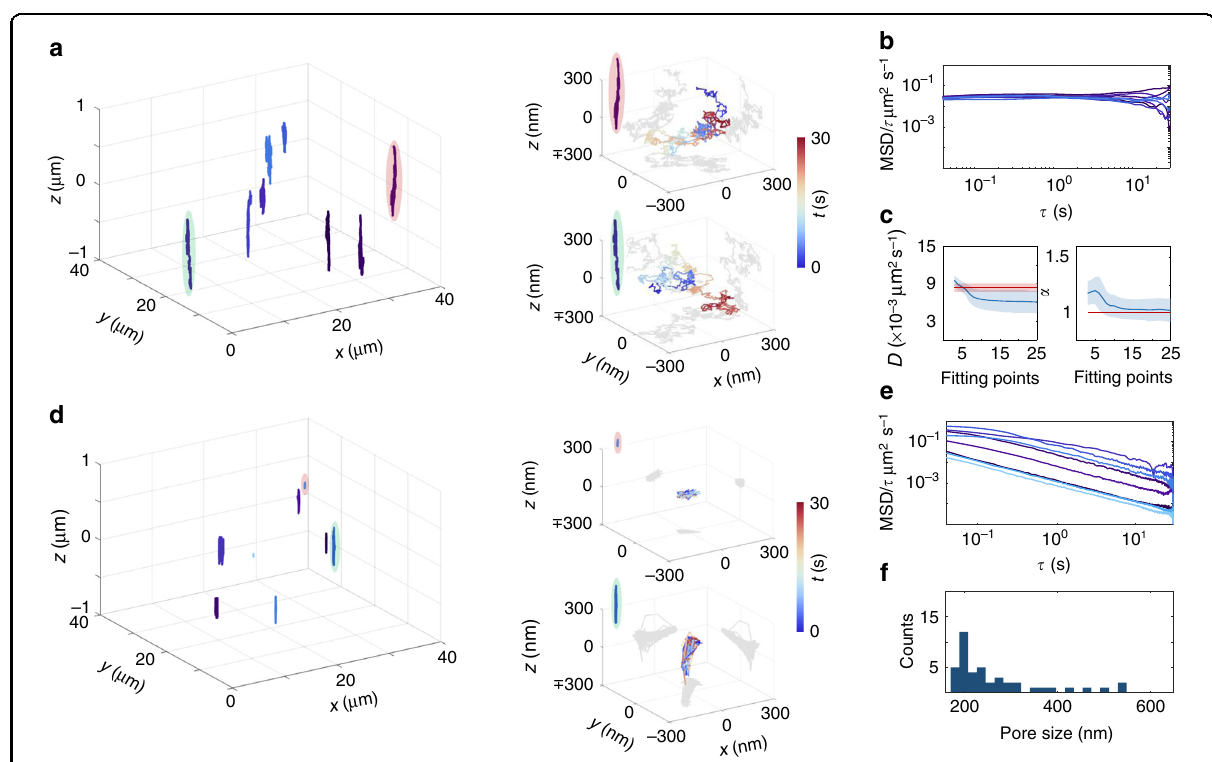
Fig. 2 3D-SPT in homogeneous and heterogeneous soft materials by TEMPSI. a 3D trajectories of multiple fl uorescent beads tracked simultaneously in a 90/10 glycerol/water mixture over 30 s at 25 3D localizations s − 1 with an average of ~11 × 10 3 photons/localization. Trajectories are presented in different colors. Zoomed trajectories of two beads marked by the green and red ovals in the left panel are also shown (right), with color re fl ecting time going from blue to red. b log – log MSD/ τ curves of the trajectories in ( a ) coded with the same color of the corresponding trajectory. The vertical axis describes the ratio of the mean square displacement to the lag time. The horizontal straight lines are characteristic of purely diffusive motion in aqueous glycerol solutions. c Diffusion coef fi cient D and exponent α as a function of the number of fi tting points ( n = 231 trajectories). Blue solid lines and shaded regions represent mean and standard deviation values of the parameters fi tted from the measured MSD curves, respectively. Red solid lines show the theoretical value of D at 20 °C and of α for a purely Brownian motion. The red shaded area in the left panel presents the theoretical values of D at 19 – 21 °C. d 3D trajectories of multiple fl uorescent beads tracked simultaneously at ~40- μ m depth in 1% agarose gel over 30 s at 25 3D localizations s − 1 with an average of ~29 × 10 3 photons/localization. Trajectories are presented in different colors (left). Zoomed trajectories of two beads marked by the green and red ovals in the left panel are also shown (right), where time is encoded as the color of the trajectory going from blue to red. The top trajectory shows con fi ned motion in a pore small compared to the pore constraining the motion described by the bottom trajectory. e log – log MSD/ τ curves of the trajectories in ( d ) coded with the same color of the corresponding trajectory. The vertical axis represents the ratio of the mean square displacement to the lag time. The negative slope lines are characteristic of constrained motion in agarose gels. f Histogram of the pore size of the agarose gel at ~40- μ m depth ( n = 46